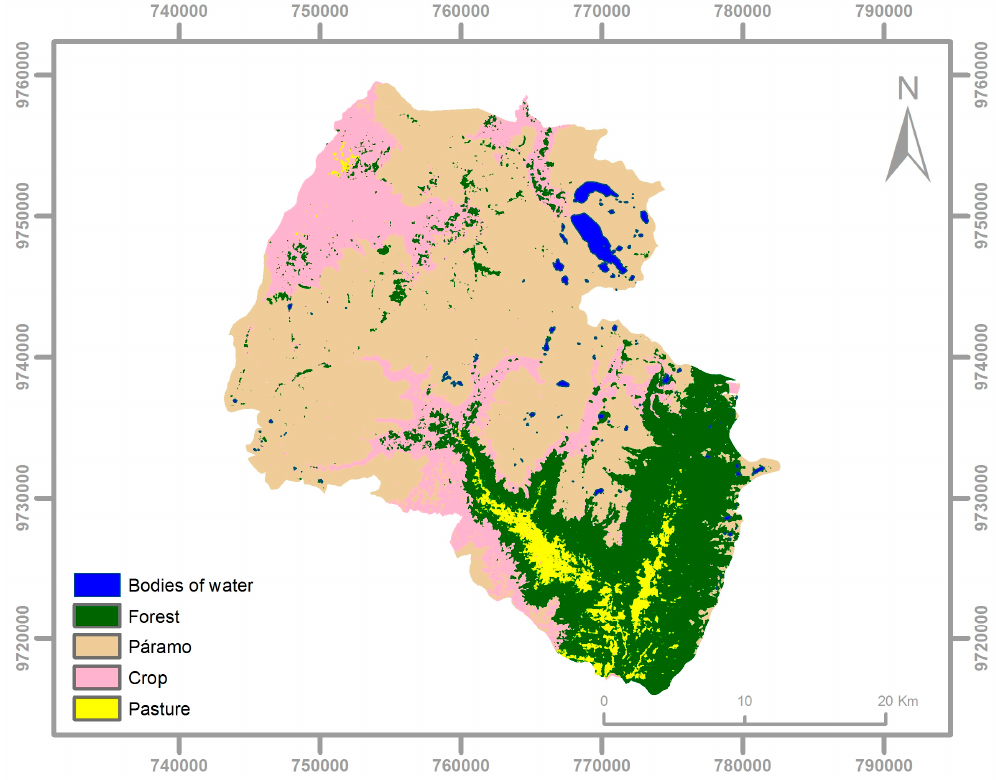
Figure 6. Map obtained from the categorization generated by the RFC of all pixels associated with the study region.